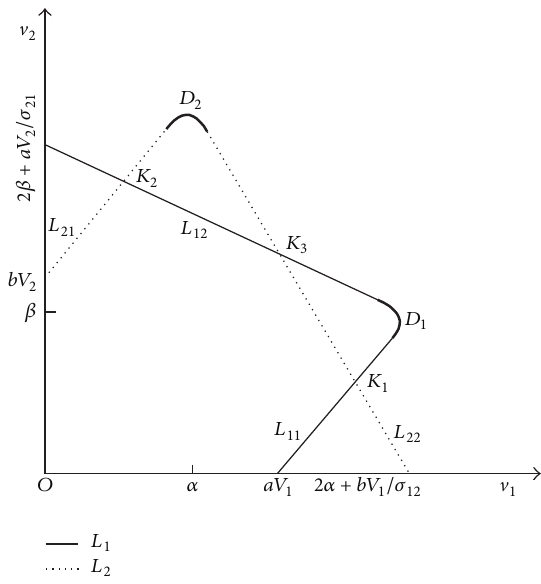
Figure 1: The smoothed parts of the isoclines 𝐿 1 and 𝐿 2